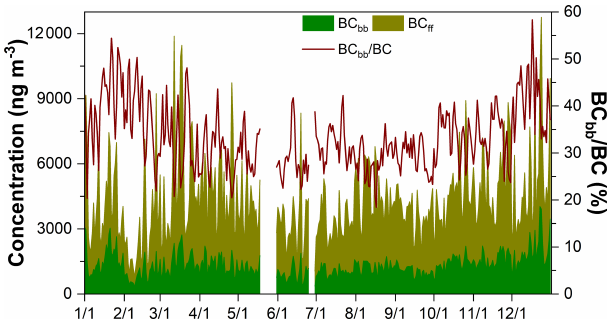
Figure 2. Daily BC ff and BC bb concentrations and BC ff / BC frac- tion in Xiamen in 2014.